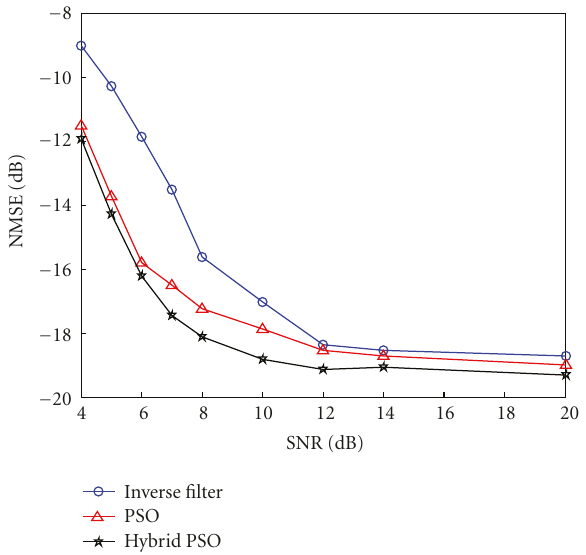
Figure 3: Comparison of NMSE for three algorithms in di ff erent SNRs.